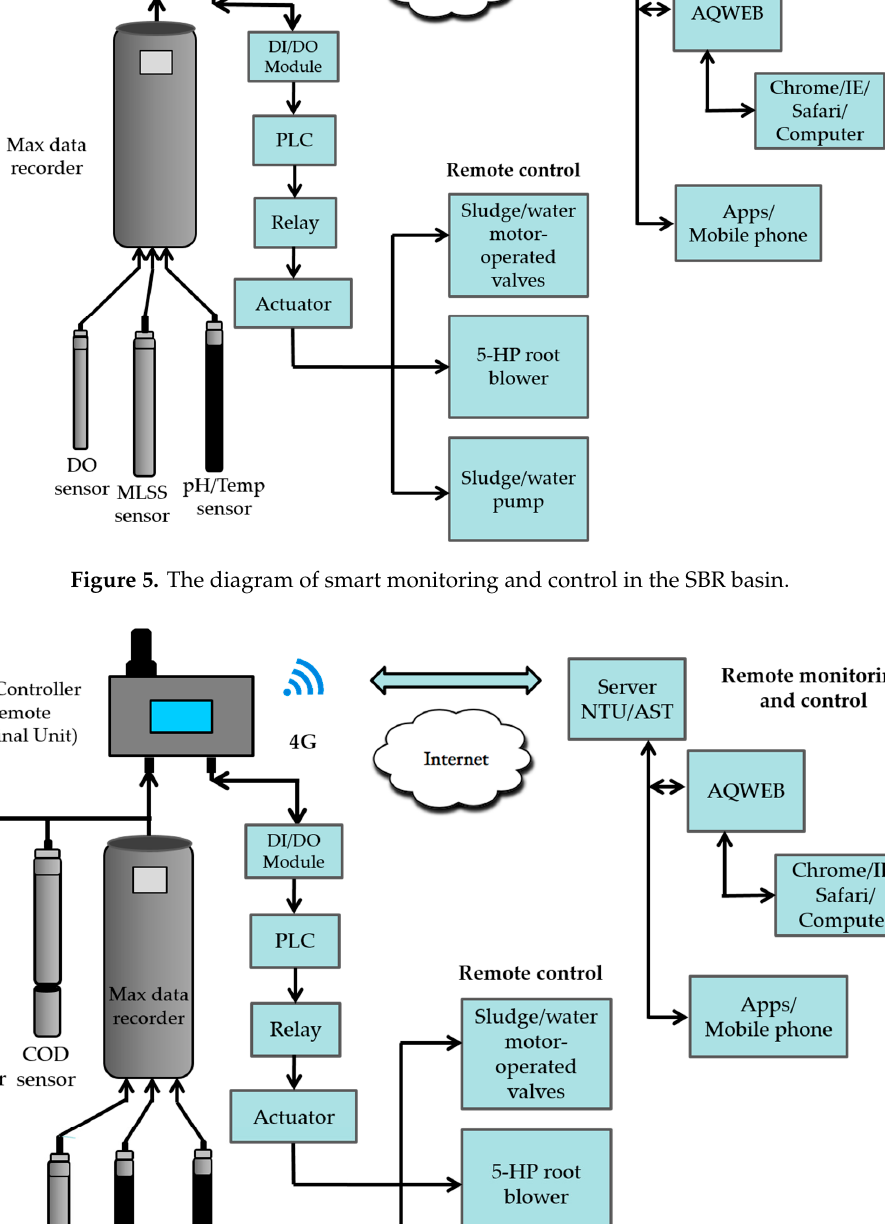
Figure 6. The diagram of smart monitoring and control in the effluent basin.